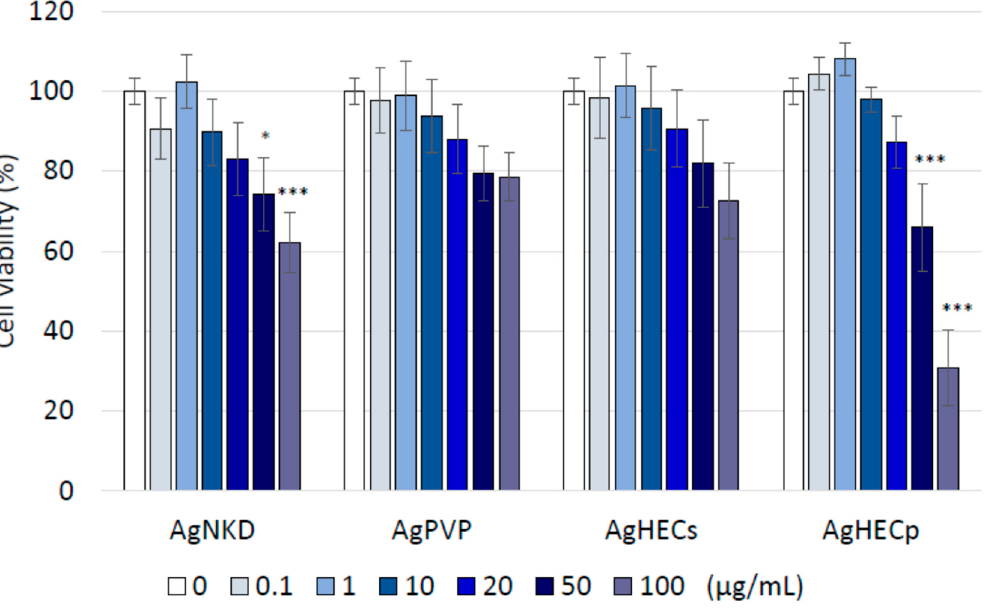
Figure A2. Cell viability assessed by MTT. Significant reduction of cell viability was observed after AgHECp and AgNKD. AgPVP and AgHECs particles were effective less. ANOVA one way followed by Dunnett test, * p < 0.05; *** p < 0.001 compared to control cells, N = 3.